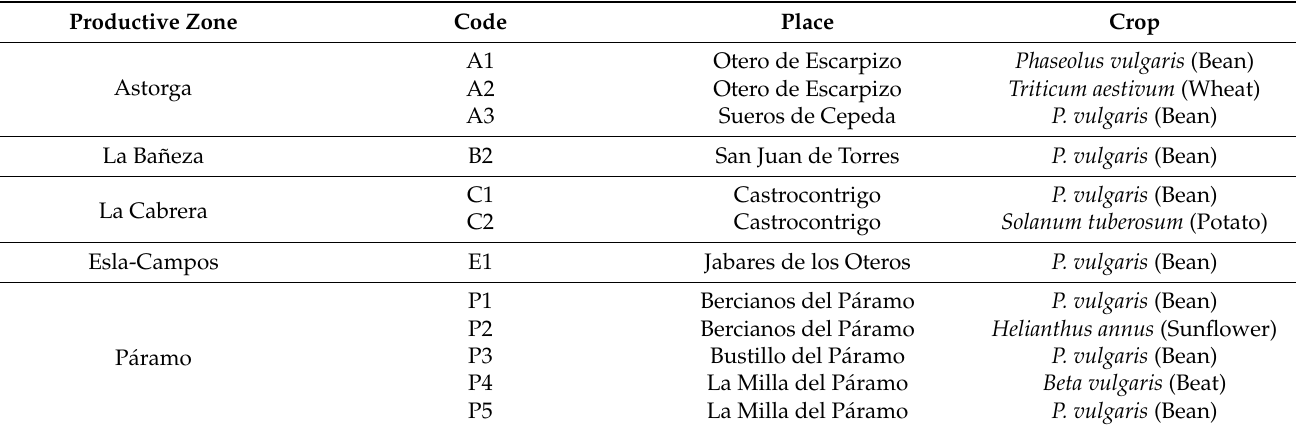
Table 1. Places and code of the soil sampling used for this